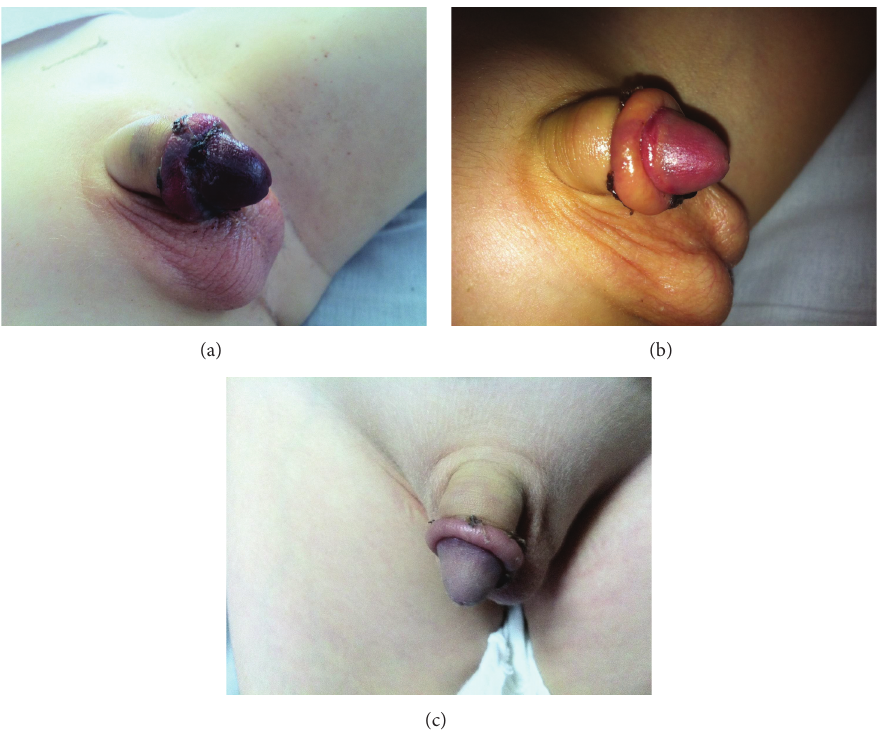
Figure 1: (a) Image of the glans and mucosa at initial presentation. (b) Image of the glans and mucosa after 48 hours of pentoxifylline treatment. (c) Image of the glans and mucosa entirely restored to normal at the end of day